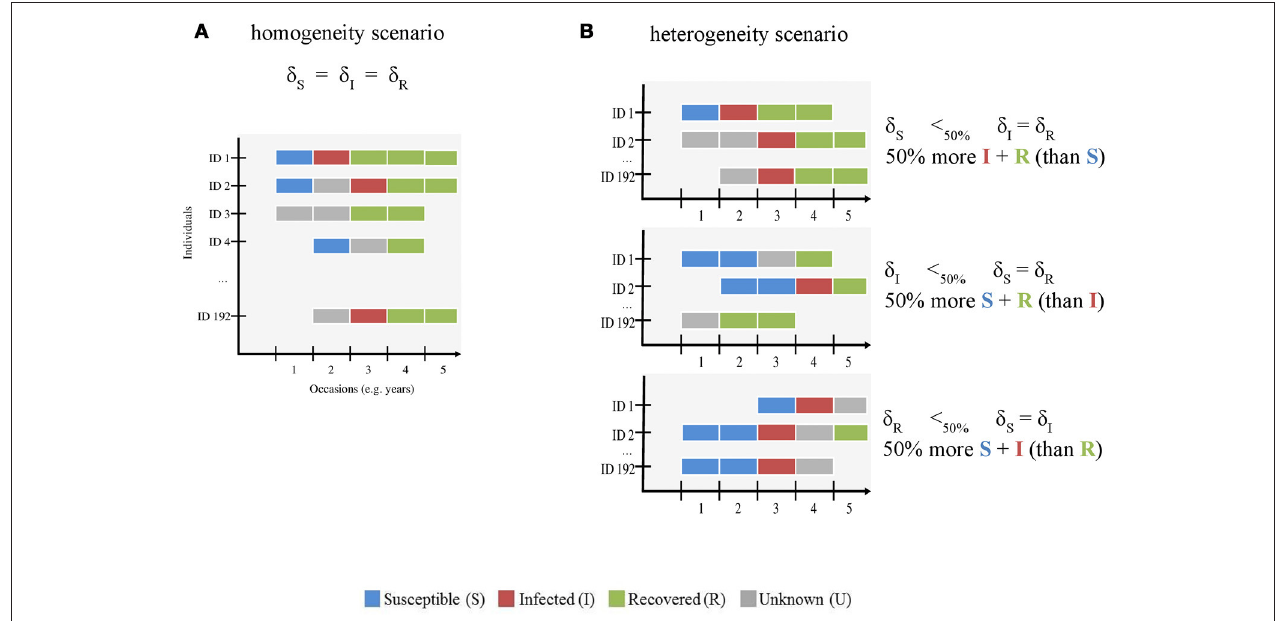
FIGURE 1 | Schematic representation of the simulated CMR data sets with (A) homogenous and (B) heterogeneous infection state uncertainty. The x-axis shows the number of occasions (here 5, see Table 1 ) and the y-axis shows the individuals (ID, here 192 individuals were simulated). This figure is meant to visually distinguish between both modeled scenarios. The gradient of uncertainty is not shown, for simplicity. For both scenarios, we used the assignment probabilities of susceptible (S) ( δ S ), infected (I) ( δ I ), and recovered (R) ( δ R ) states to simulate variation in infection state uncertainty. S, I, R and unknown (U) states are shown in blue, red, green, and gray, respectively. In the homogeneity scenario (A) , we gradually increased uncertainty by decreasing the probability of assigning each infection state by an equal amount in the simulated data set. In the heterogeneity scenario (B) , we varied the assignment probability of all states across a gradient as for (A) and reduced the value of one state by 50% compared to the other two. For instance, in the first case (right panel, top figure), the number of S states (blue) is lower than that of I (red) and R (green)